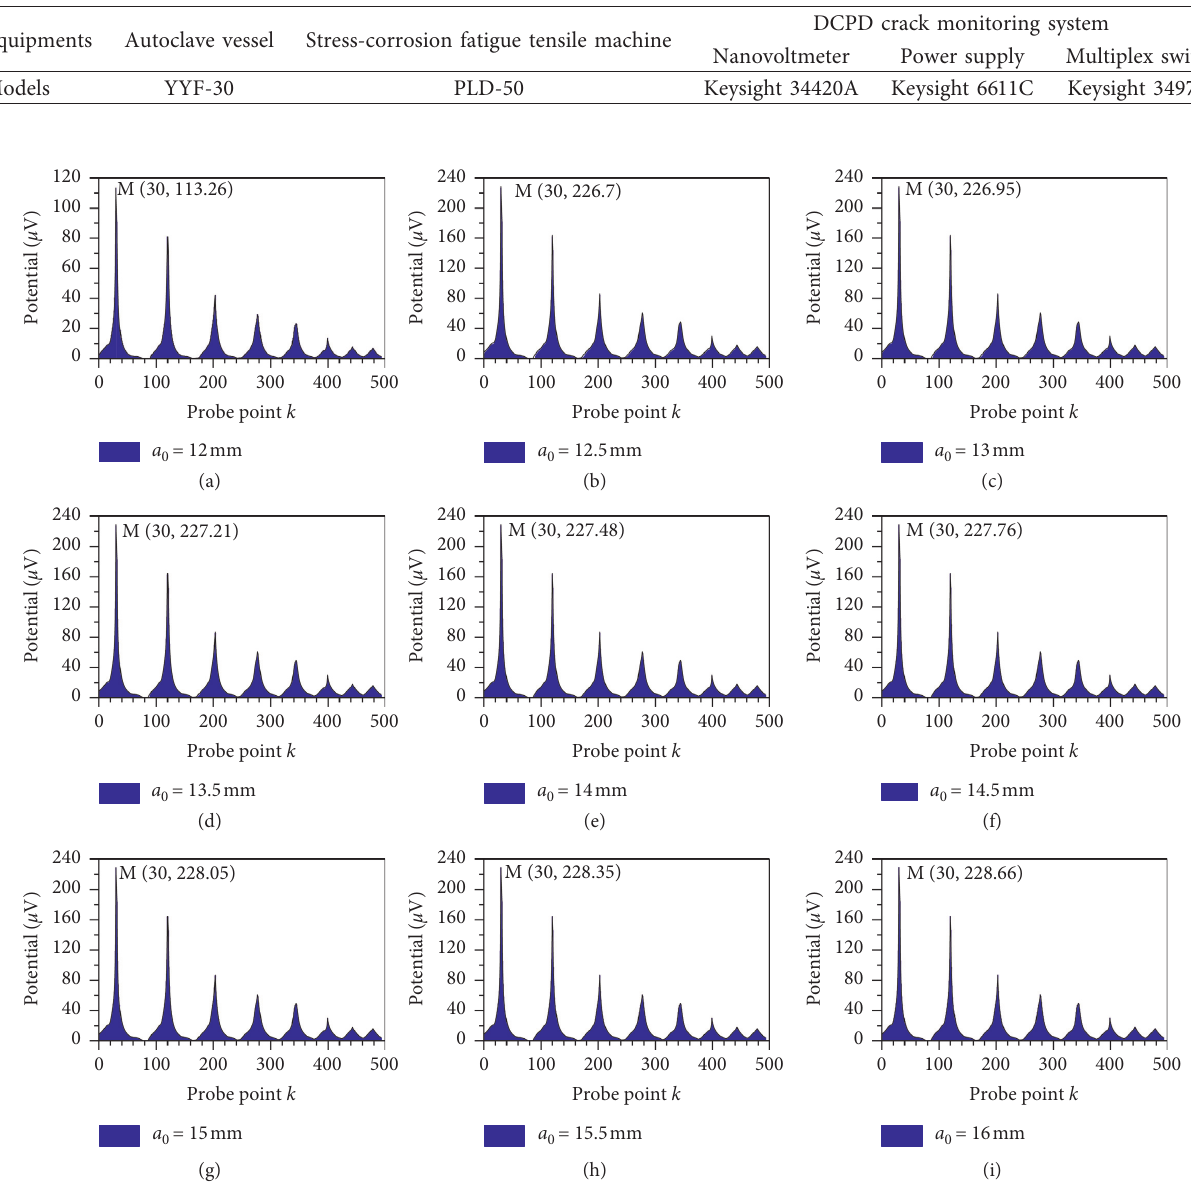
Table 2: Experimental equipment and model of crack monitoring.